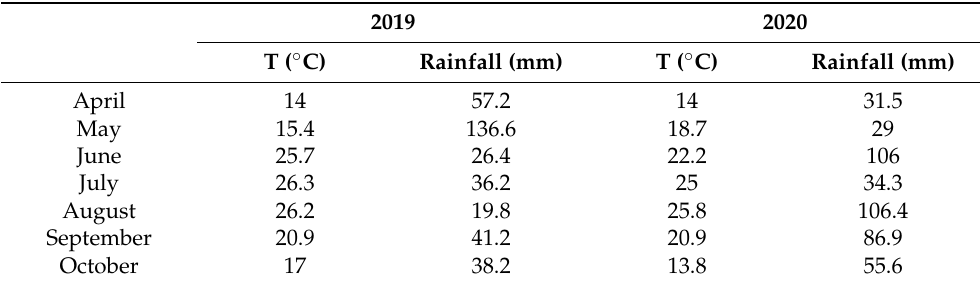
Table 1. Monthly average temperature and rainfall recorded for the growth period (April–October) in 2019 and 2020 at a weather station close to the vineyard.